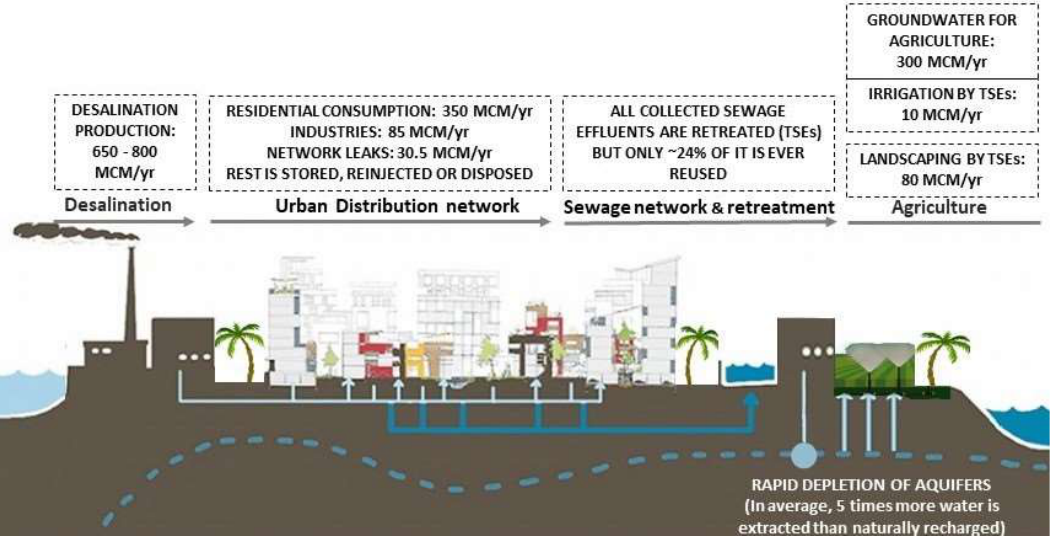
Figure 1. Qatar WEF Nexus